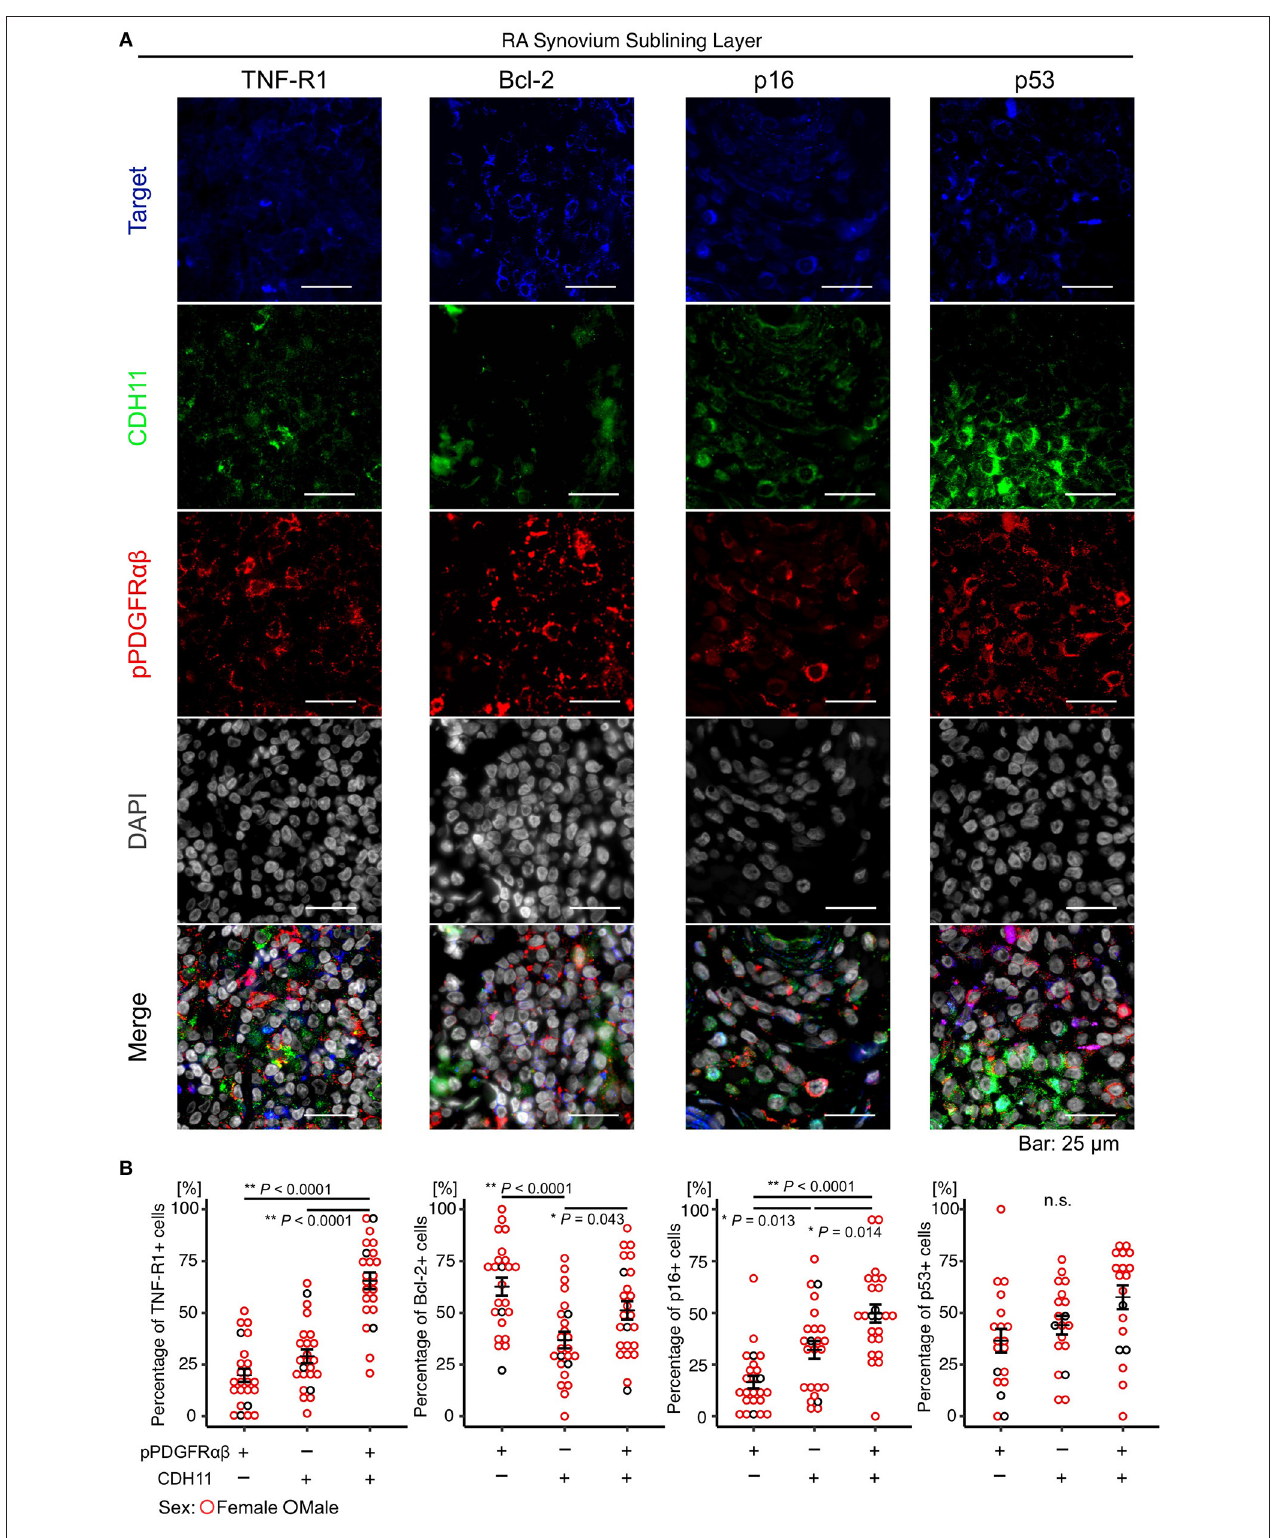
FIGURE 2 | The pPDGFR αβ + CDH11– cells that accumulated in the SL of the synovium in RA exhibited reduced TNF-R1 and p16 expression and increased Bcl-2 expression. (A) representative staining images showing pPDGFR αβ , CDH11, TNF-R1, Bcl-2, p16, and p53 expression in the RA-SL. (B) quantitative expression data for TNF-R1, Bcl-2, p16, and p53 in 3 cell populations (pPDGFR αβ + CDH11–, pPDGFR αβ -CDH11 + , pPDGFR αβ + CDH11 + cells). The percentage of TNF-R1-positive